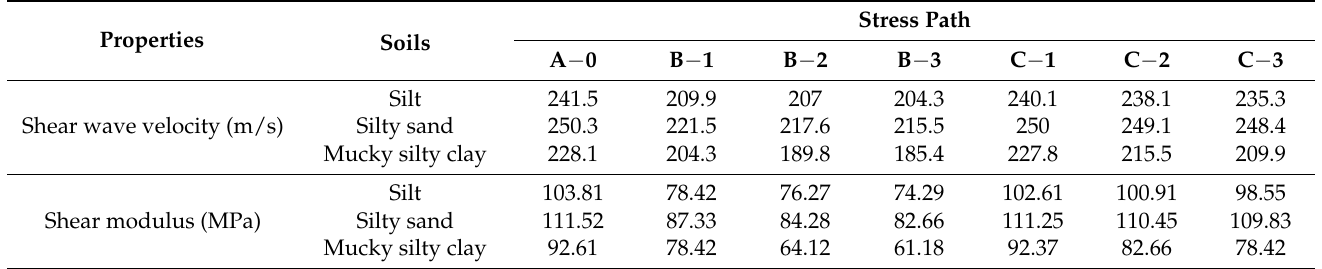
Table 7. Experimental results of shear wave velocity and shear modulus under different stress paths.